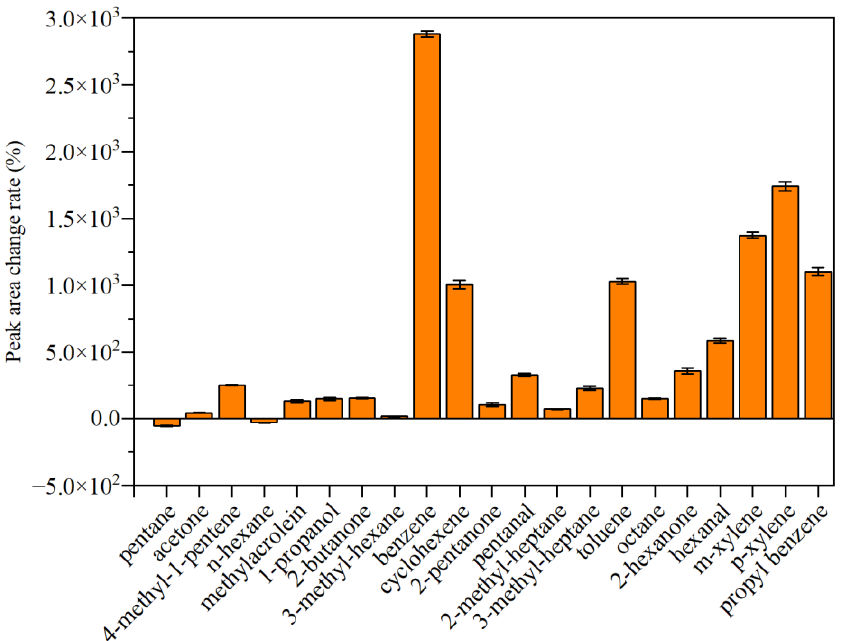
Figure 5. Peak area changes of 21 compounds in Area 1 based on the GC-MS chromatograms of the CRMB binder.